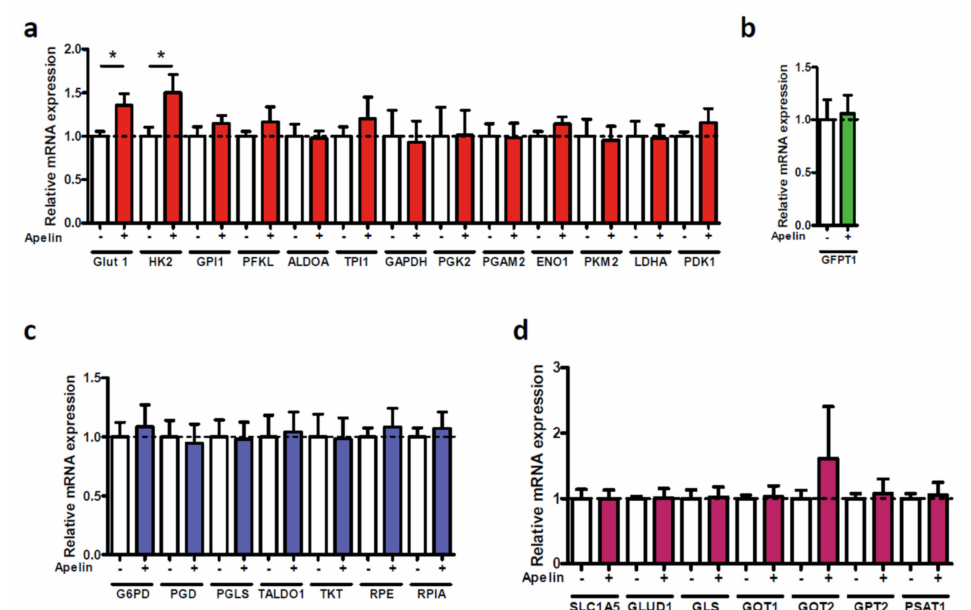
Figure A7. Effects of Apelin stimulation on glycolysis, hexosamine, phosphate pentose pathways and glutaminolysis. Effects of Apelin (500 nM) stimulation on the expression of glycolysis-related genes ( a ), genes involved in hexosamine pathway ( b ), the phosphate pentose pathway ( c ) and glutaminolysis ( d ) in MiaPaCa-2 cells. Paired t -test (two-tailed) was used to compare the differences between groups (*) p ≤ 0.05.